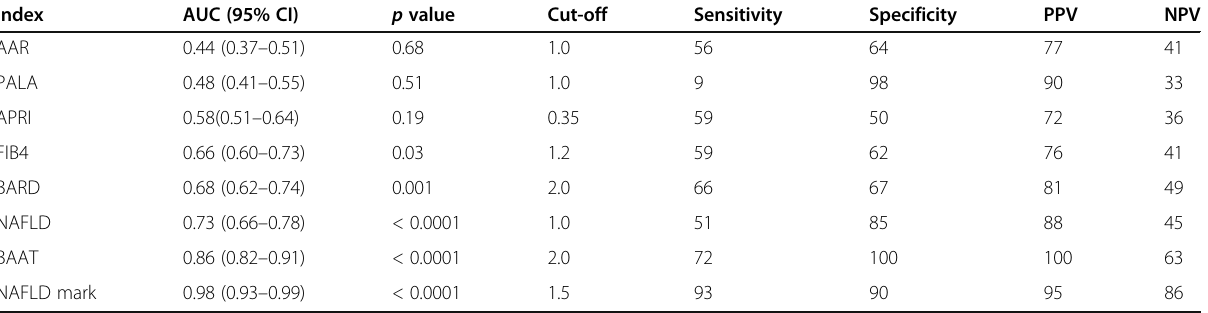
Table 3 Evaluation of NAFLD mark vs non-invasive models for NAFLD Index AUC (95% CI) p value